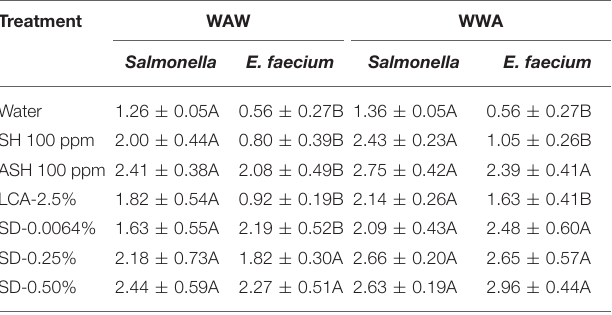
TABLE 7 | A comparison of the reduction of Salmonella and surrogate E. faecium on cucumbers (log CFU/cucumber) by triple-wash procedure WAW) or WWA in water, SH (100 ppm, pH 8.2), ASH (SH, 100 ppm, pH 6.8 adjusted by citric acid), LCA (Veggiexide ® , 2.5%), and a PAA and hydrogen peroxide mix (SD, 0.0064, 0.25, and 0.50%).